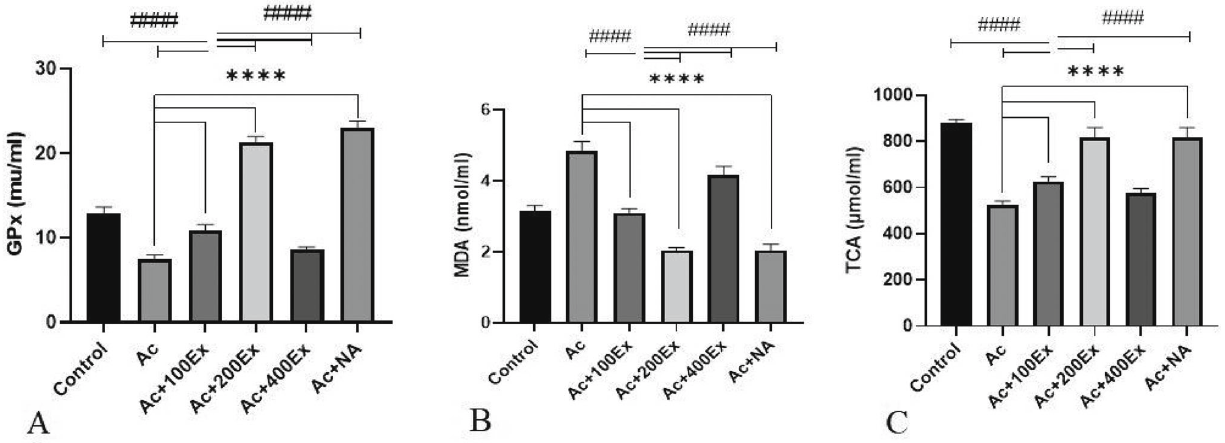
Figure 1: Changes in serum oxidative stress parameters in di ff erent groups. ****Di ff erence between control and Ac groups with other groups ( P < 0 : 001 ). #### Di ff erence between treatment groups with each other ( P ≤ 0 : 001 ).